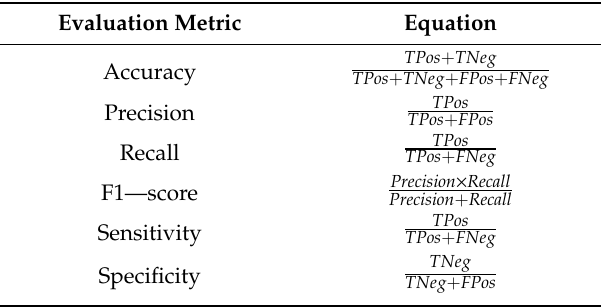
Table 2. Evaluation Metrics used in the proposed